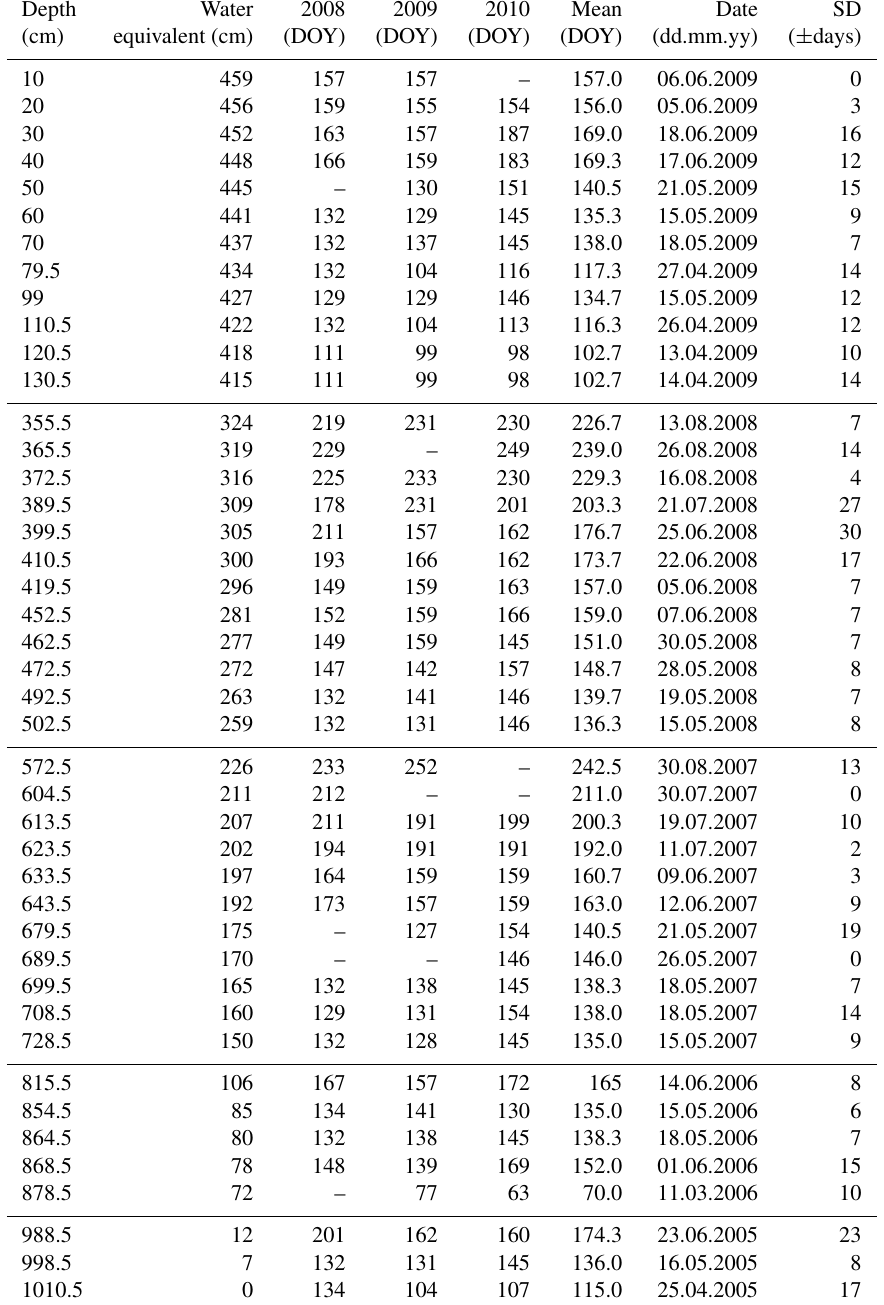
Table 1. Results of the depth-to-day matching obtained by similarity analyses between Mt. Ortles snow samples and pollen monitoring data from Solda from the years 2008 to 2010. DOY is day of the year. Samples are ordered according to their depth in the